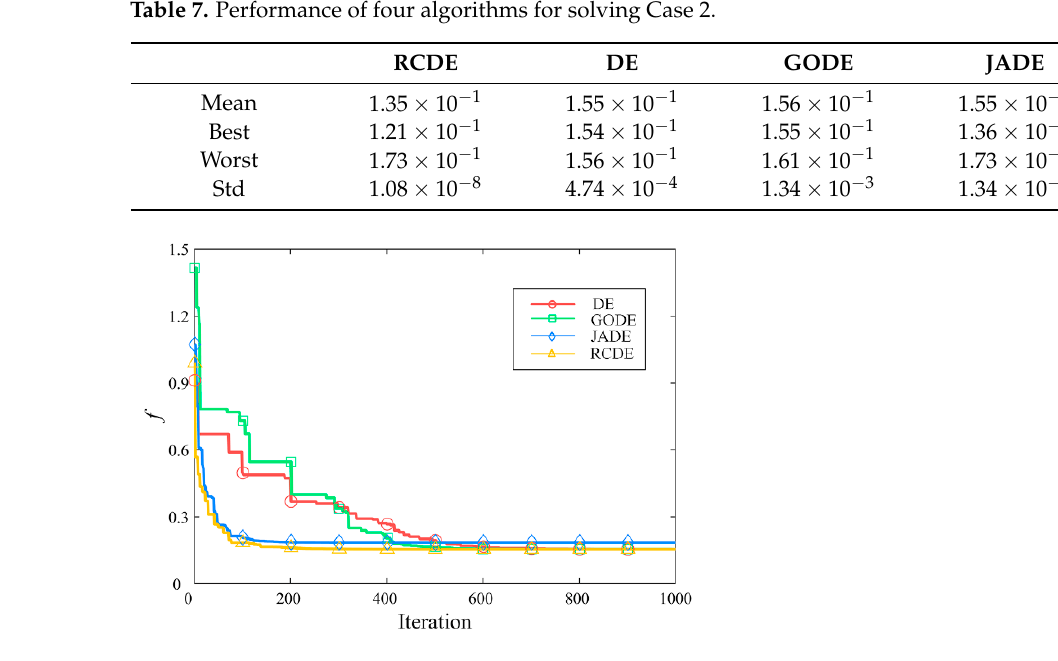
Figure 10. Convergence curves of the four algorithms in Case 2.